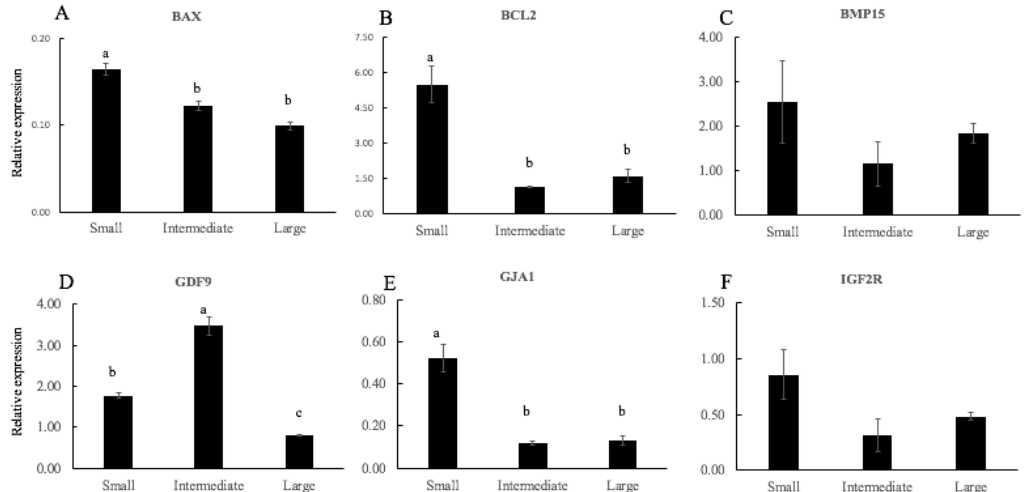
Figure 2. Relative gene expression of mRNA of BAX ( A ), BCL2 ( B ), BMP15 ( C ), GDF9 ( D ), GJA3 ( E ), and IGF2R ( F ) in ovine oocytes according to the clustering of total diameter (small, intermediate, or large). Different letters denote significant differences ( p < 0.05, at least).